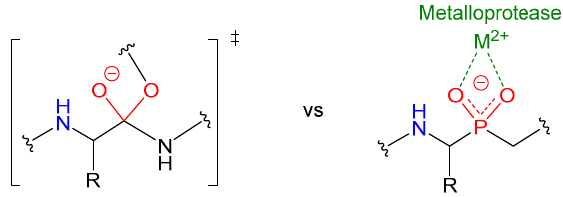
Figure 2. Similarity between the transition state of peptide hydrolysis and the α -amino- C -phosphinic motif. The additional interaction with the metal ion in the metalloproteases active site is included.